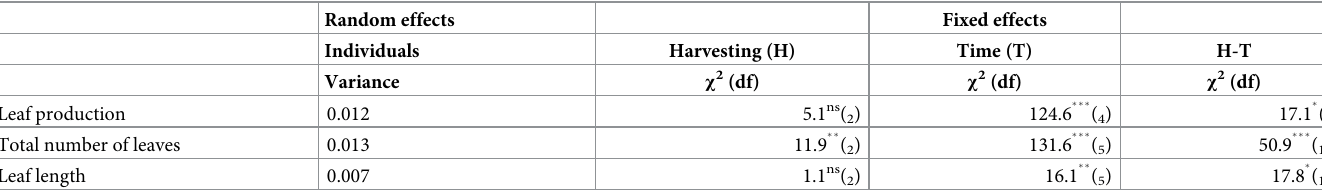
Table 1. Results of the statistical analyses on leaf traits to evaluate the effects of chronic defoliation on Brahea aculeata in the tropical dry forest of A´lamos,